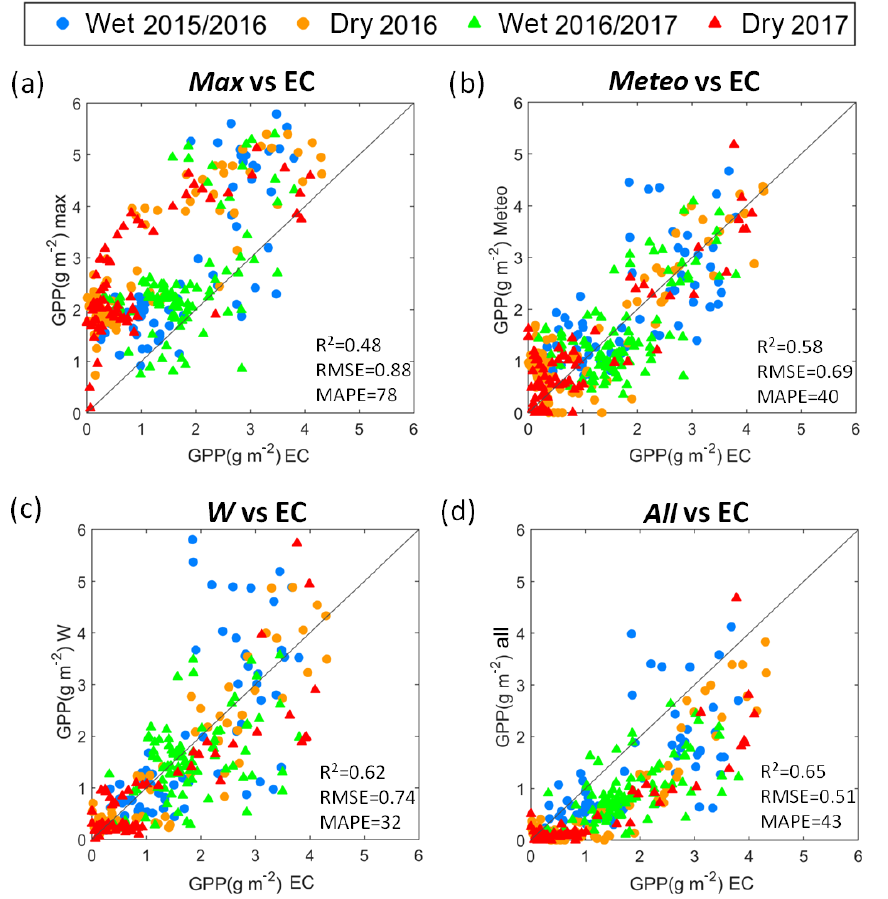
Figure 4. Comparison of GPP measured by the EC vs. max (a) , EC vs. meteo (b) , EC vs. W (c) and EC vs. all (d) . Blue: wet period; orange: dry period; circle: 2015/2016; triangle: 2016/2017; black line: 1 : 1